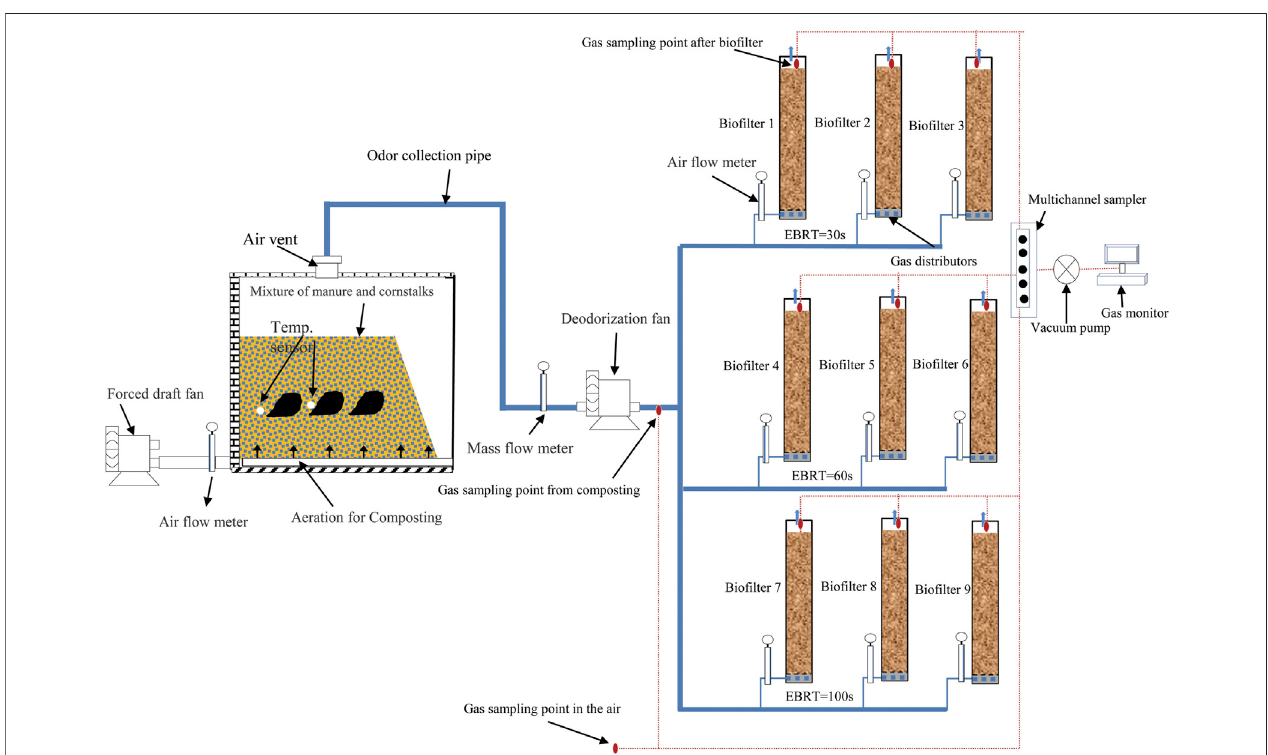
FIGURE 1 | Schematic representation of the composting and the bio fi ltration